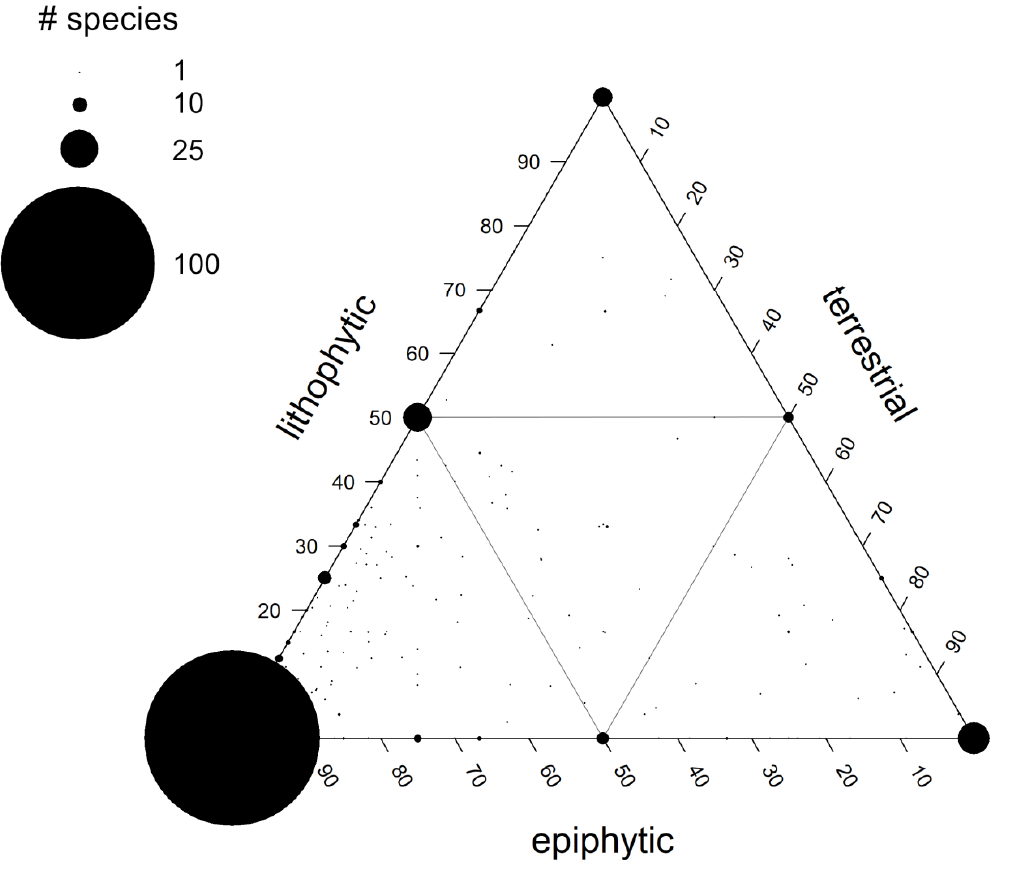
Figure 2. Distribution of 450 species of filmy ferns including members of all nine accepted genera in the epiphyte-lithophyte-terrestrial space. The number of species with a preference for epiphytic growth, i.e., E ≥ 50, was 304 (note that in this calculation we assigned half of the species at the border, e.g., EV = LV = 50% to E and L). Symbol size varies with the number of species that share the same values. Individual species values are based on 1 – 45 sources. The grey lines separate three zones of preference for epiphytic, lithophytic or terrestrial growth, with the central triangle being occupied by generalists. The full data set is given in Tables S1 and S2.